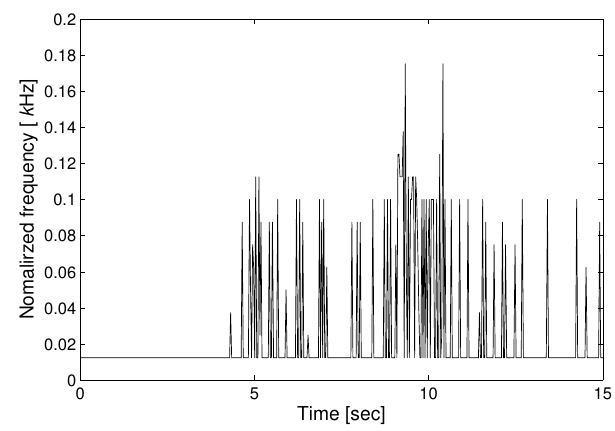
Figure 7. IF analysis of the seismic